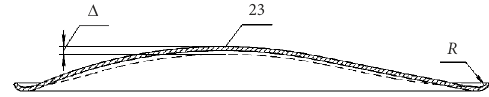
Figure 2. Scheme for changing the shape of offset mirror antenna blank during stamping in a